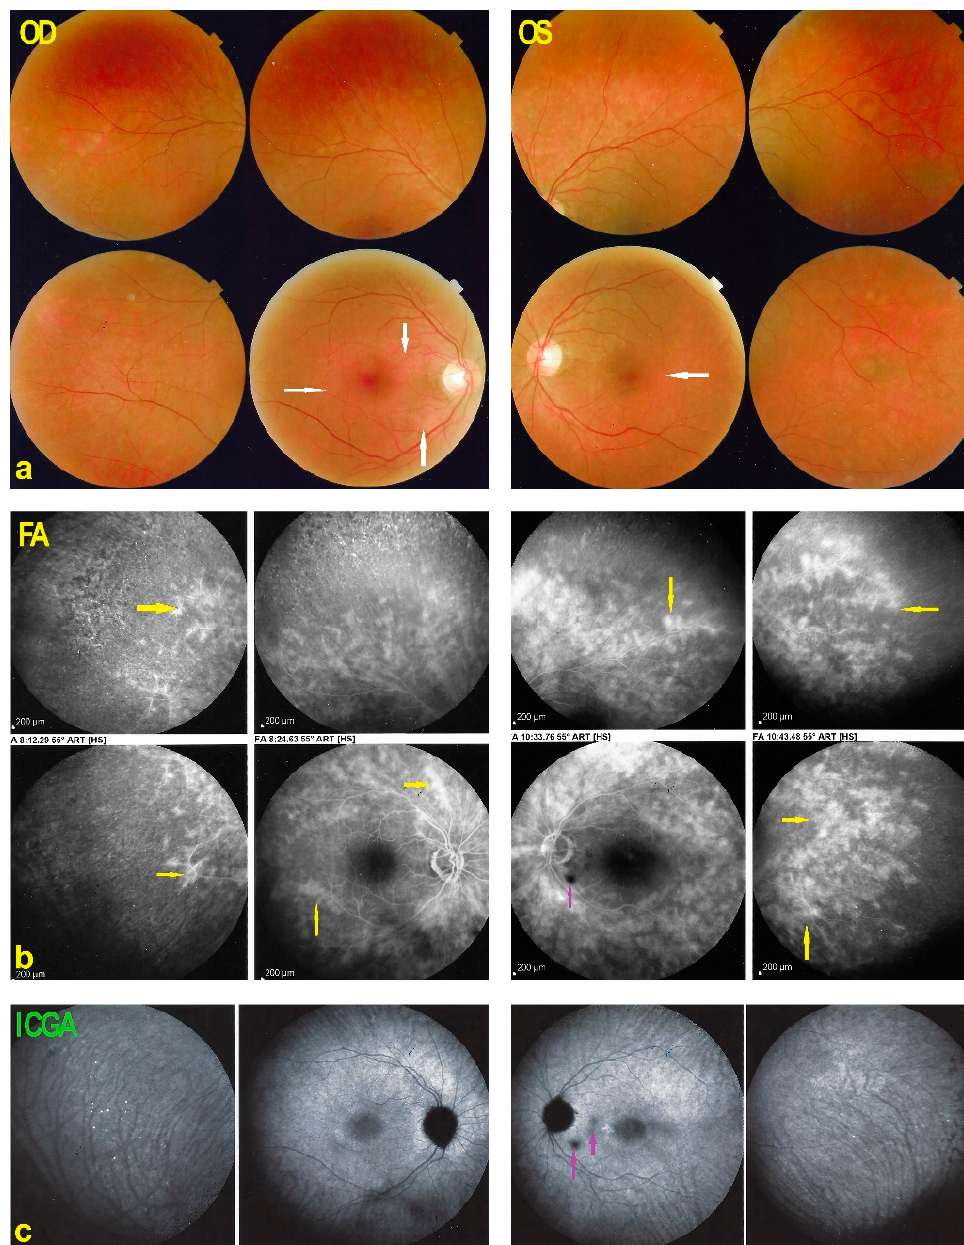
Figure 10. Fundus, FA and ICGA of AZOOR patient 3 at presentation. ( a ) Fundus shows bilateral discolored rings around fovea (white arrows). ( b ) FA shows extensive peripheral retinal vasculitis ODS (yellow arrows). Late ICGA frames present ICGA fluorescence indicating conserved choriocap- illaris except for two interpapillo-macular dark dots ( c , crimson arrow) in the left eye also present on the FA image ( b , crimson arrow).